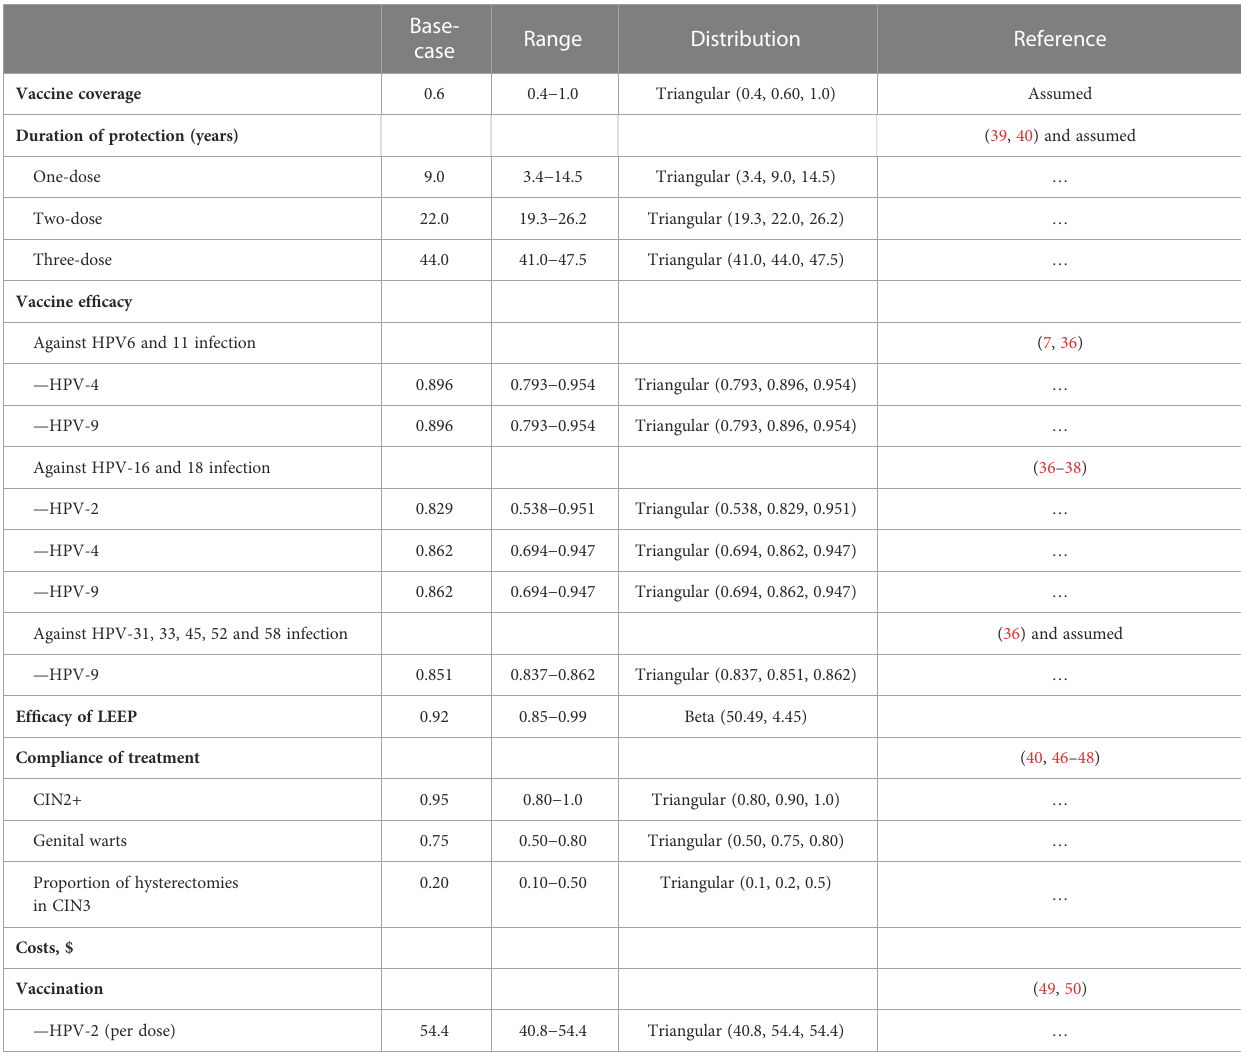
TABLE 1 Variables used in the